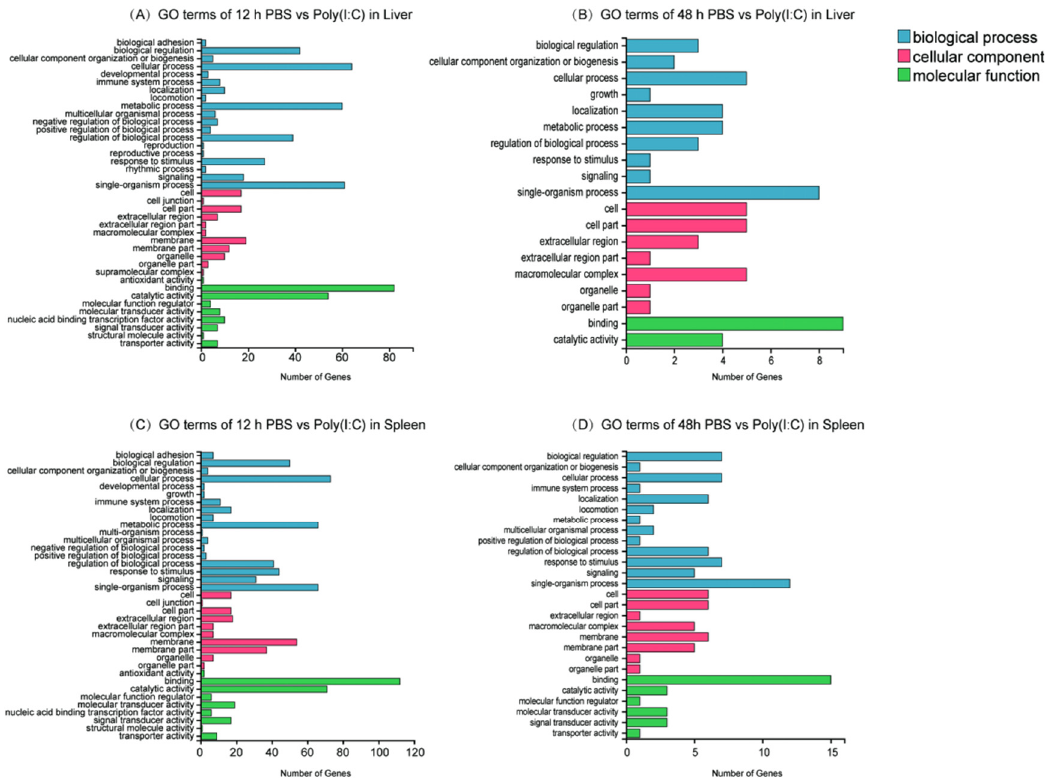
Figure 2. GO Enrichment of Differentially Expressed Genes in Both Tissues at Different Times: ( A ) Represents the Result of GO Enrichment in Comparative Case of 12 h PBS vs Poly (I:C) in the Liver; ( B ) Represents the Result of GO Enrichment in Comparative Case of 48 h PBS vs Poly (I:C) in the Liver; ( C ) Represents the Result of GO Enrichment in Comparative Case of 12 h PBS vs Poly (I:C) in the Spleen; ( D ) Represents the Result of GO Enrichment in Comparative Case of 48 h PBS vs Poly (I:C) in the Spleen.